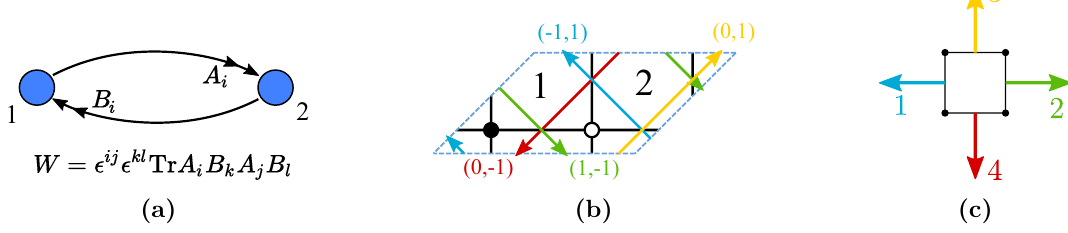
Figure 1. Conifold: (a) quiver diagram and superpotential, (b) dimer diagram with ZZPs and their windings, and (c) toric diagram with outward normals corresponding to ZZPs up to an SL(2 , Z )